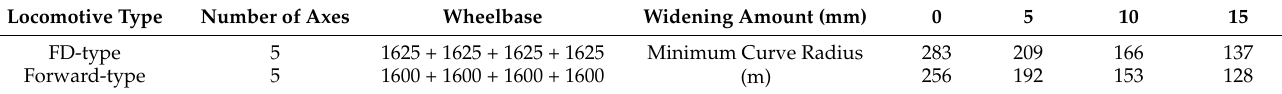
Table 12. Gage widening values in Chinese railways (1983)